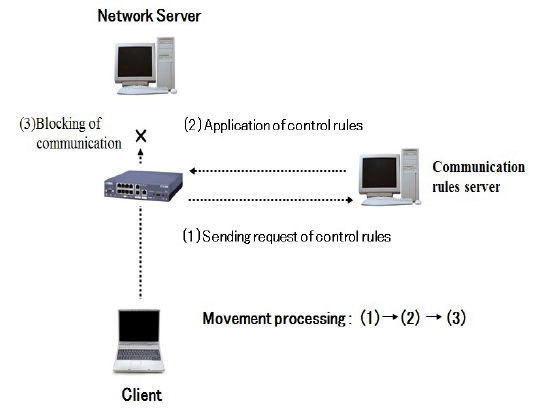
Figure 1. Principle in First Scheme